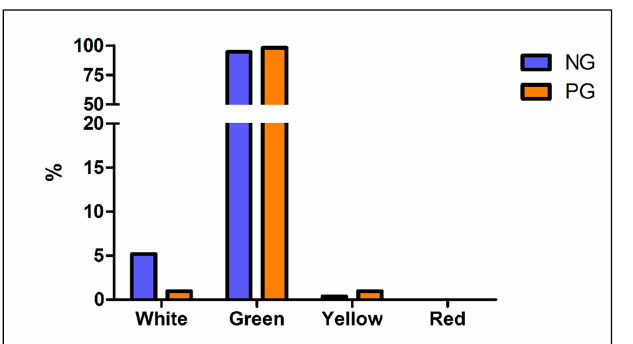
Figure 1. Triage code at ER admission: differences between NG and PG. Legend: NG: Non-pandemic Group PG: Pandemic Group.